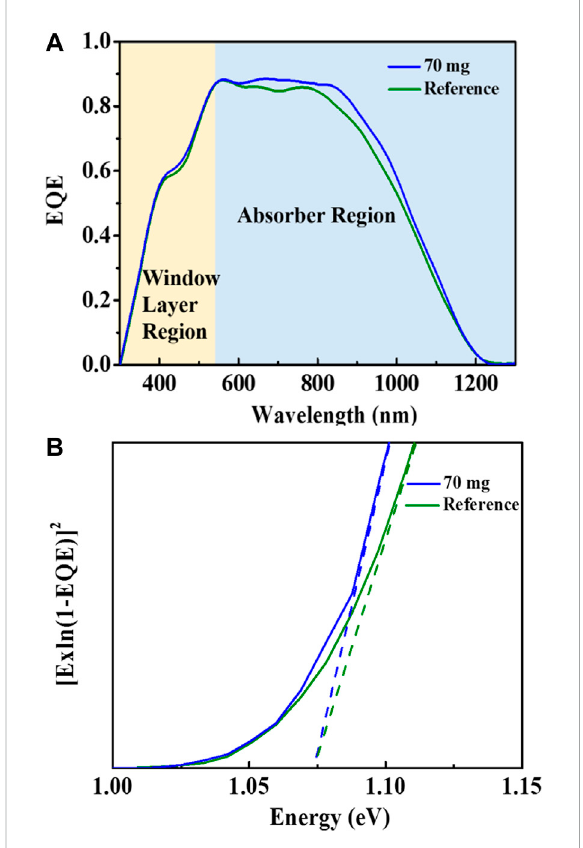
FIGURE 5 EQE curves (A) and bandgap estimation (B) of the champion pristine CZTSSe device and Sb doped-CZTSSe device.